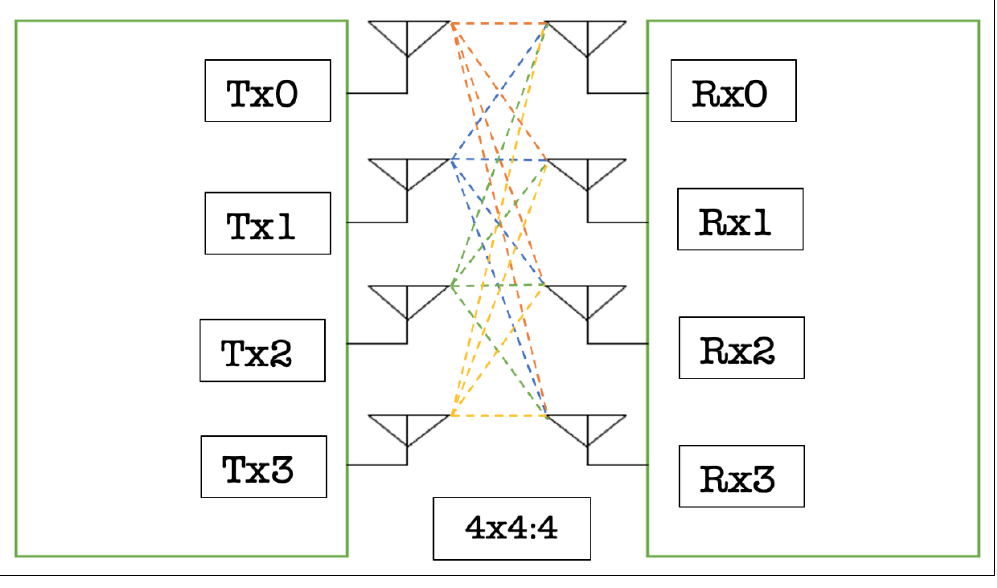
Figure 3. a) MIMO